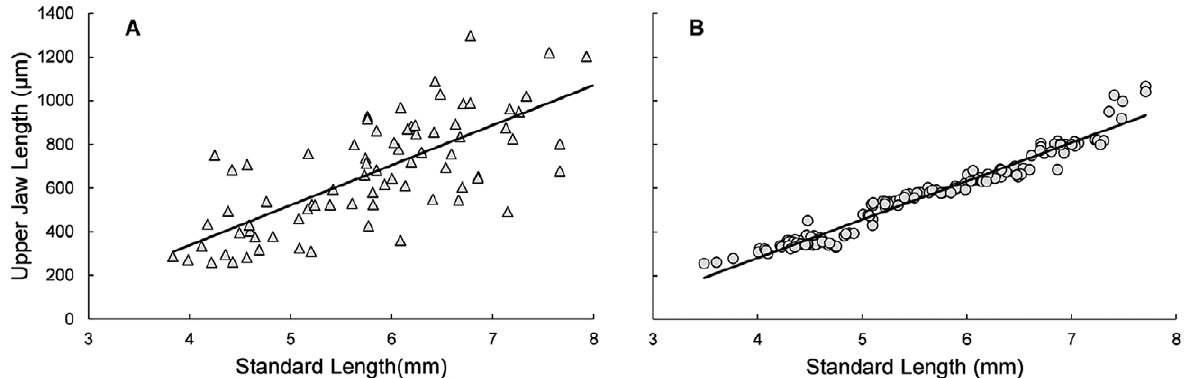
Fig 3. – Relationship between standard length (mm) and upper jaw length (μm) for larval sandperch. Left panel, Prolatilus jugularis (trian- gles); right panel, Pinguipes chilensis